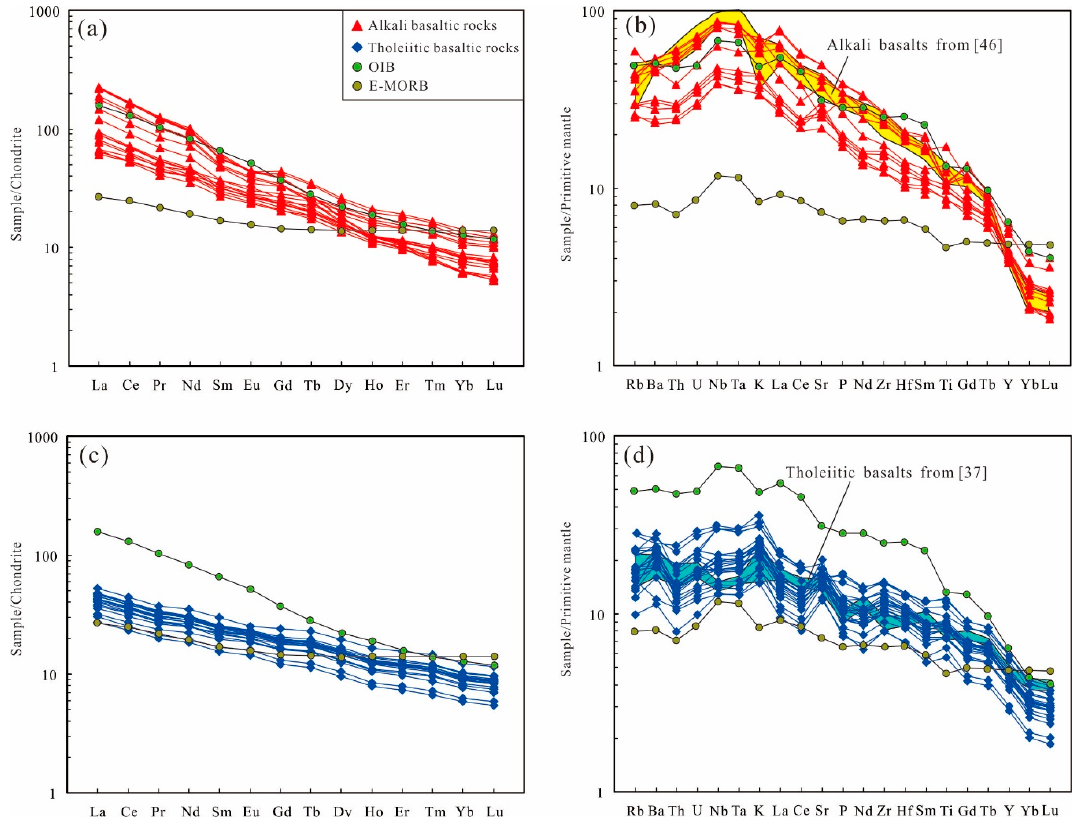
Figure 8. Chondrite-normalized REE patterns ( a and c ) and primitive mantle normalized trace element diagrams ( b and d ) for the samples from the Qianjiadian region. The values of chondrite and primitive mantle are from Boynton [54] and Sun and McDonough [55], respectively.